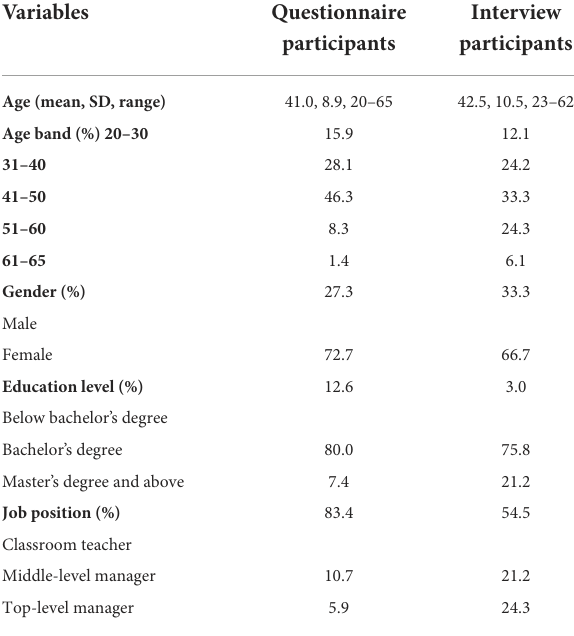
TABLE 1 Demographic characteristics of participants in the two elements of the study.